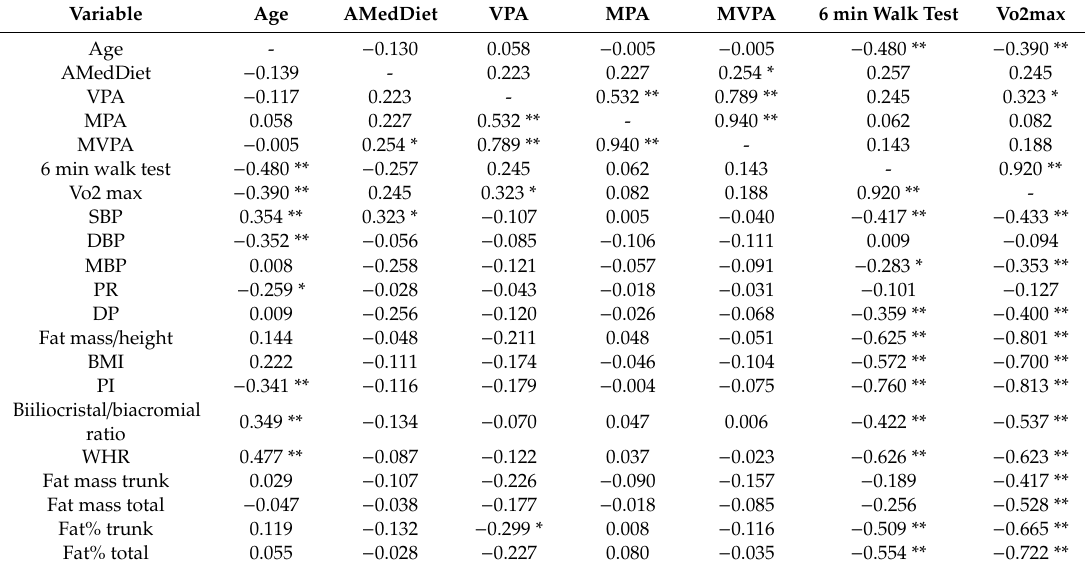
Table 2. Bivariate correlations between age, cardiovascular variables, adherence to the Mediterranean diet, physical activity, and cardiorespiratory fitness.